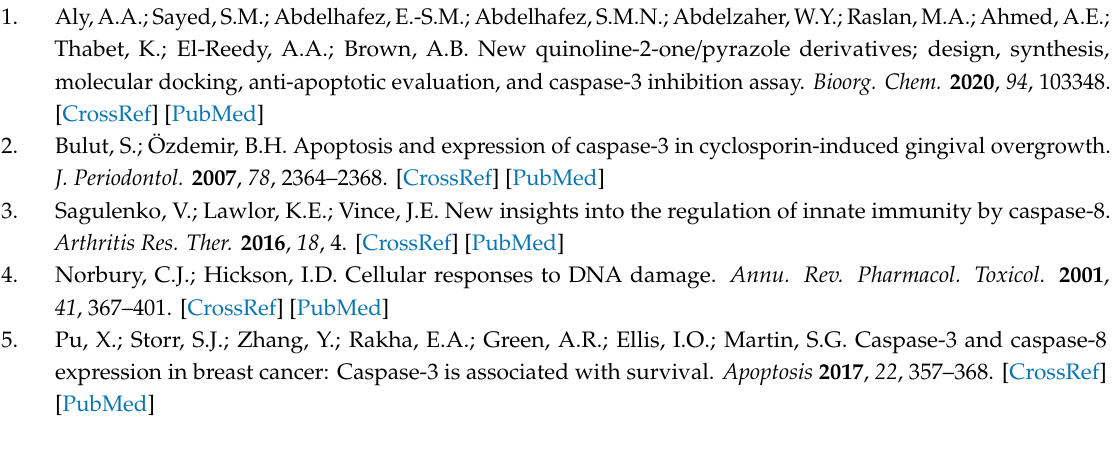
Supplementary Materials: The following are available online, Figure S1: 2D and 3D diagrams illustrate the binding modes of the reference NAC and 6a-g interacted with the active site of caspase-3 (PDB: 3GJQ), Table S1: E ff ect of compounds 6c and NAC on the active Cell-based caspases-3, 8 and 9 in MOLT-4 cell line, Table S2: Energy scores for the complexes formed by the tested compounds 6a-g and the reference NAC in the active site of caspase-3 (PDB: 3GJQ), Table S3: Testicular MDA and Testicular TAC concentrations in testis of I / R rats treated with compounds 6a – g and NAC, Table S4: Testicular testosterone and TNF α concentrations in testis of I / R rats treated with compounds 6a – g and NAC, Table S5: Caspase-3 level in serum of testicular I / R rats treated with compounds 6a – g and